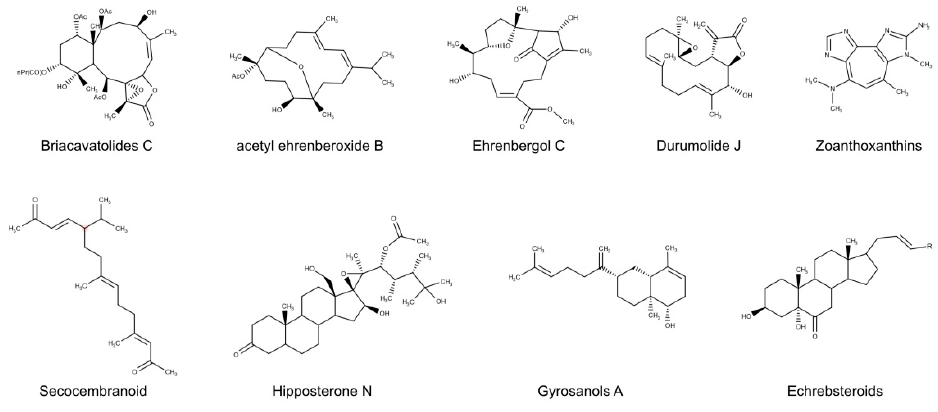
Figure 5. Compounds from cnidarians.